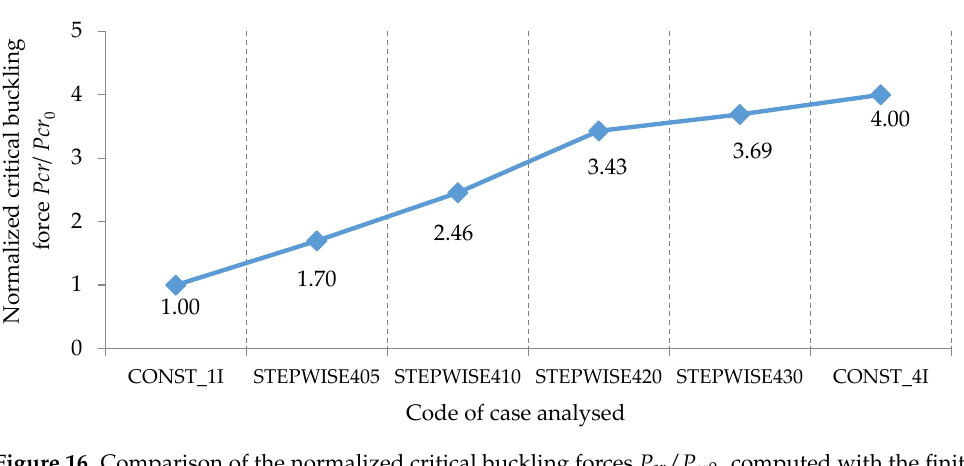
Figure 16. Comparison of the normalized critical buckling forces P cr / P cr 0 . computed with the finite element models for the bars involved (details about each case are given in Table 2).